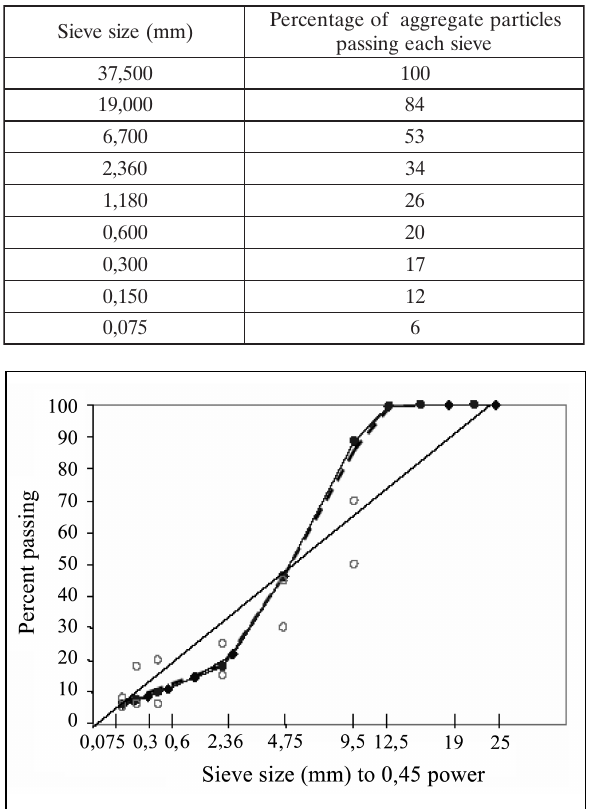
Table 2. Mix properties and test results [10]